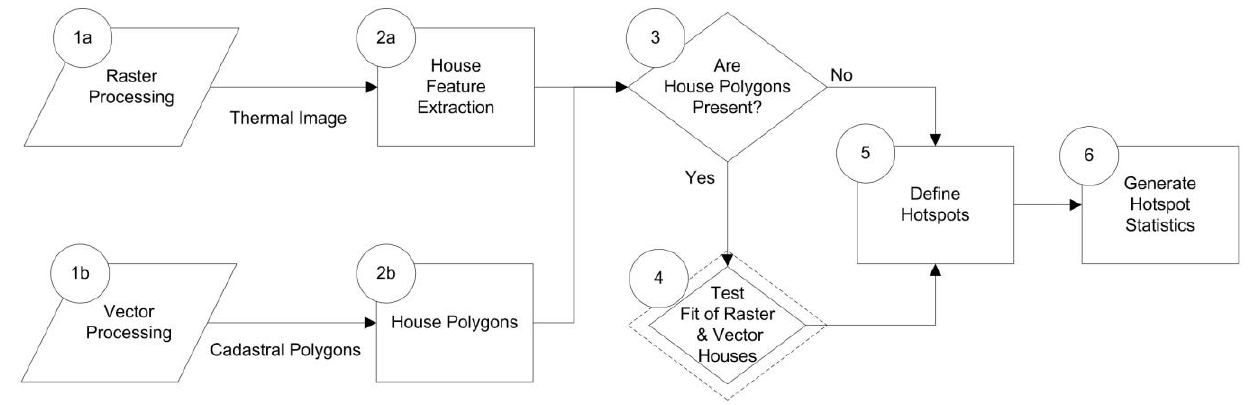
Figure 7. The Hot Spot processing flow-diagram, showing paths for both raster and vector data.